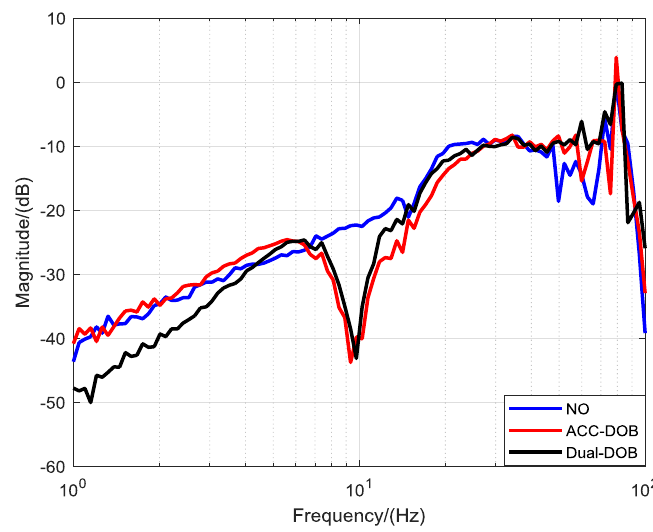
Figure 12. Comparison of the disturbance rejection characteristics of three structures.